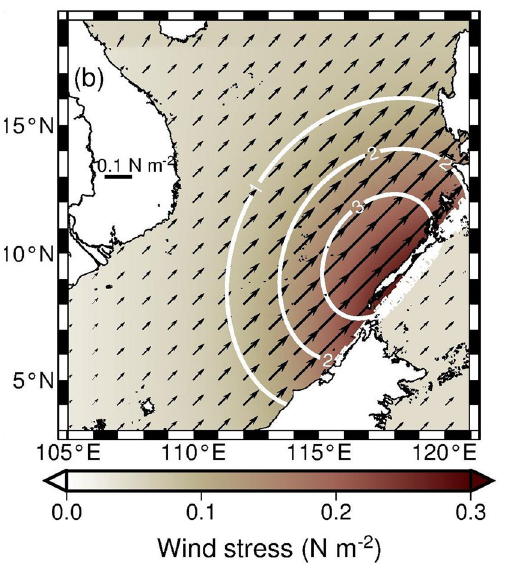
Figure 5. Spatial distribution of the maximum wind stress in the model. The length of each arrow represents the magnitude of wind stress. The white contours are constant values of wind stress curl (× 10 –7 N m –3